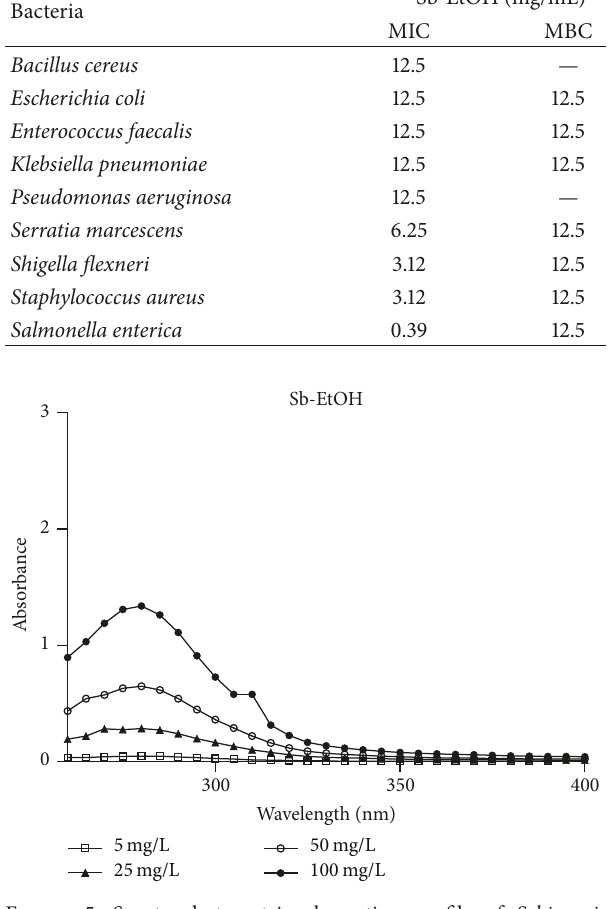
Figure 5: Spectrophotometric absorption profile of Schinopsis brasiliensis extract (260–400 nm).